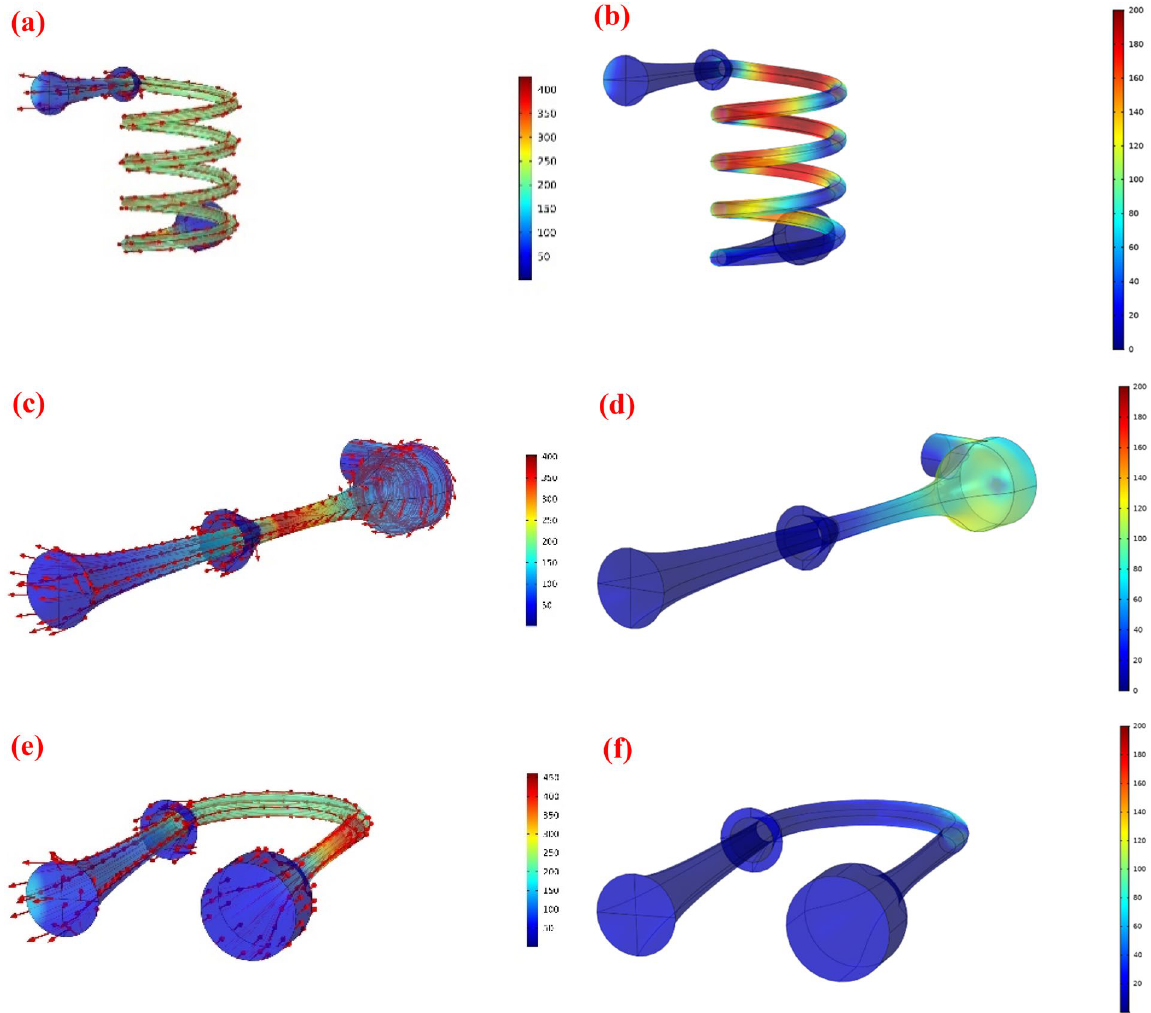
Figure 9. Velocity profile (m/s) ( a , c , e ) and swirl velocity distribution (m/s) ( b , d , f ) for various swirler